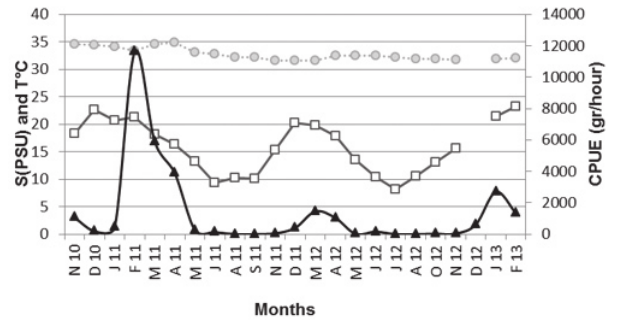
Fig. 3. Captures per unite effort (CPUE), temperature and salinity values obtained for Anchoa marinii . Black triangles: CPUE; open squares: temperature; circles with dotted line: